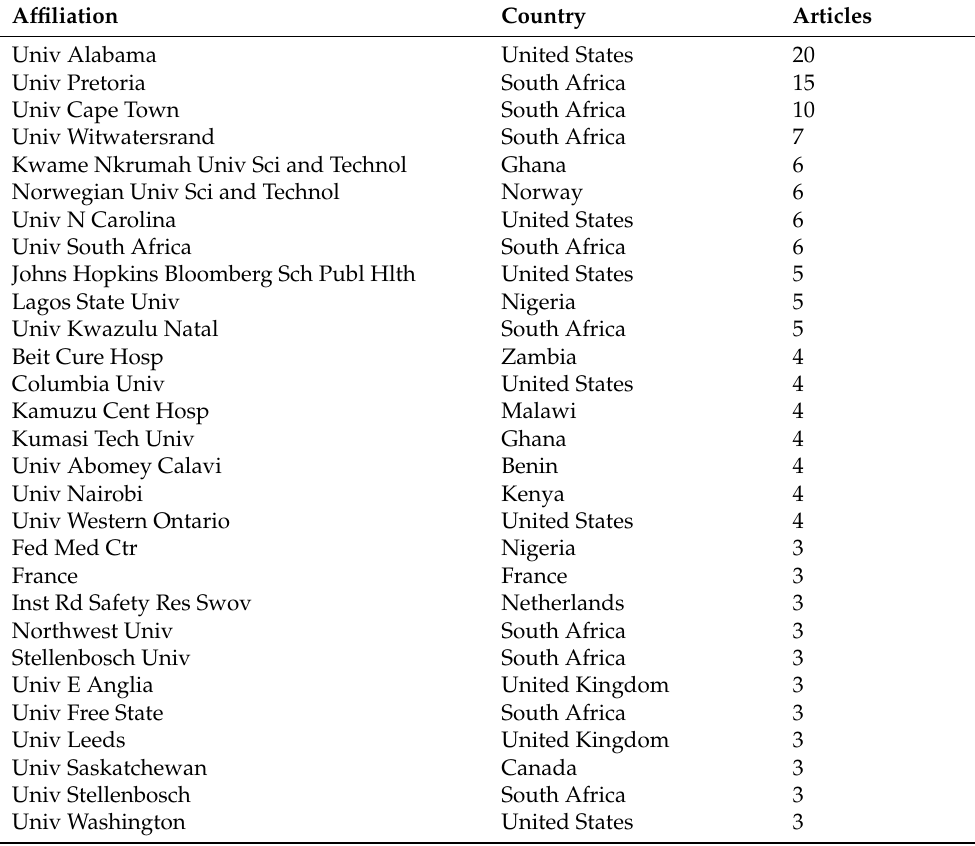
Table 4. Author affiliations.